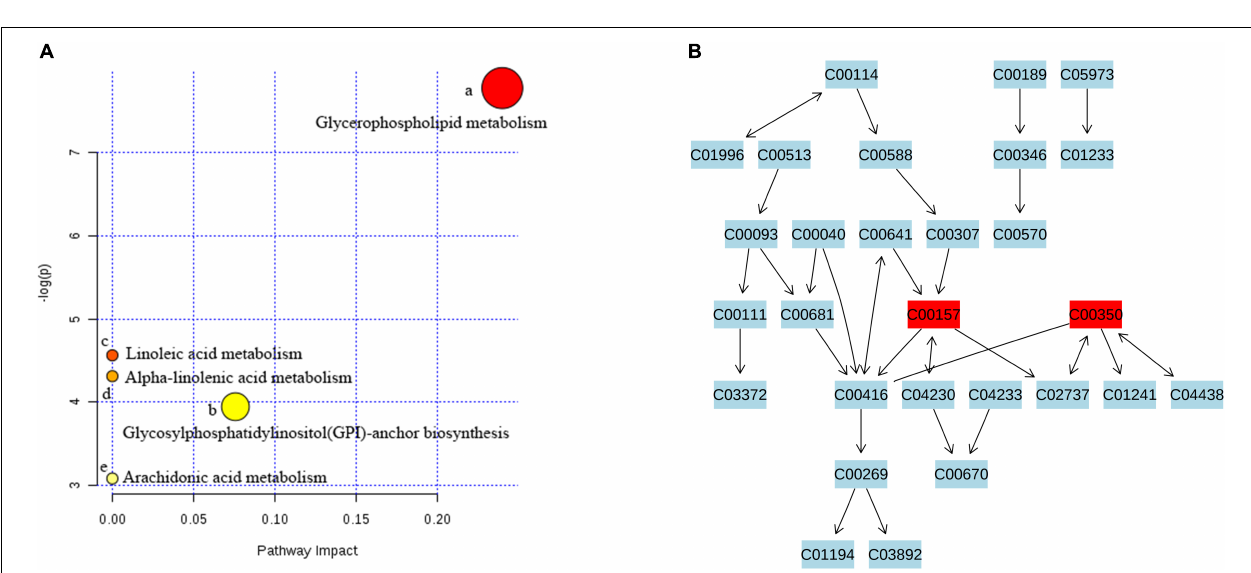
Frontiers in Physiology |